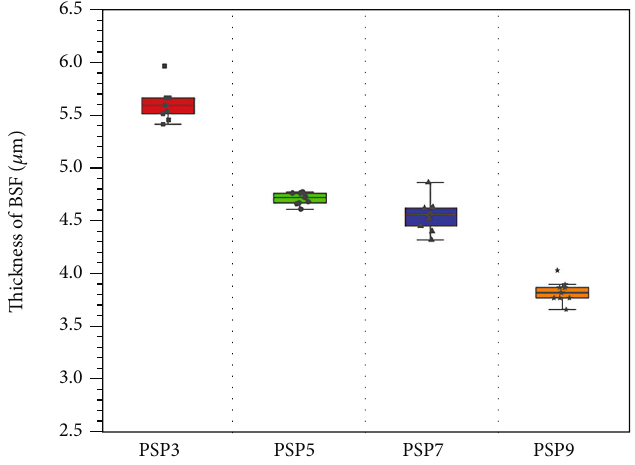
Figure 9: The BSF thickness of di ff erent Al